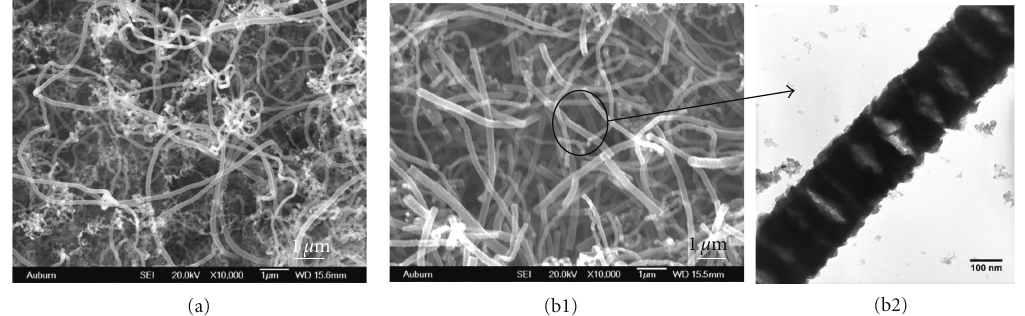
Figure 10: Synthesized CNF for e ff ect of 20% NH 3 on di ff erent pretreated foils: (a) SEM of CNF on 715 ◦ C reduction pretreatment, (b1) SEM of CNF on 815 ◦ C faceting pretreatment, and (b2) TEM of b1. Synthesis conditions: 2% C 2 H 2 , 20% NH 3 , 78% H 2 , and 570 ◦ C (Table 1 (Phase 4C)).